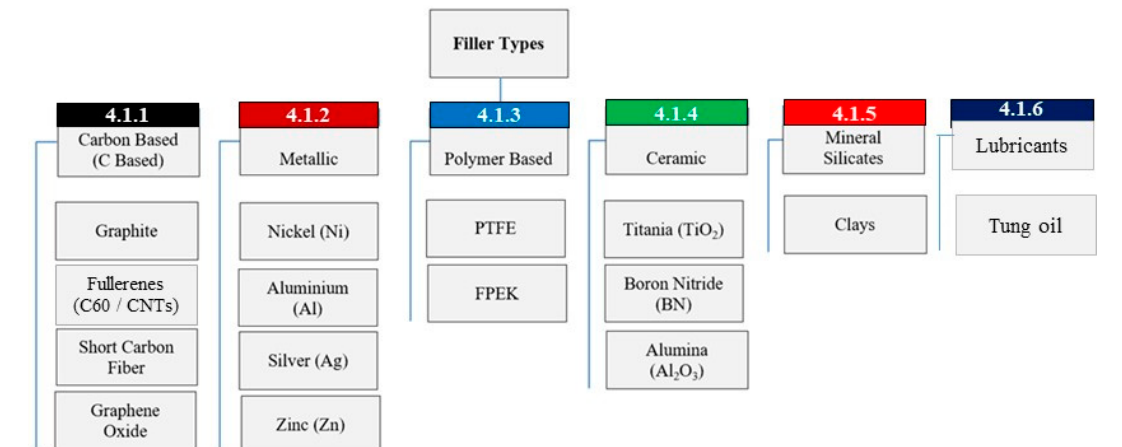
Figure 2. Classification of different fillers used to reinforce epoxy matrix.